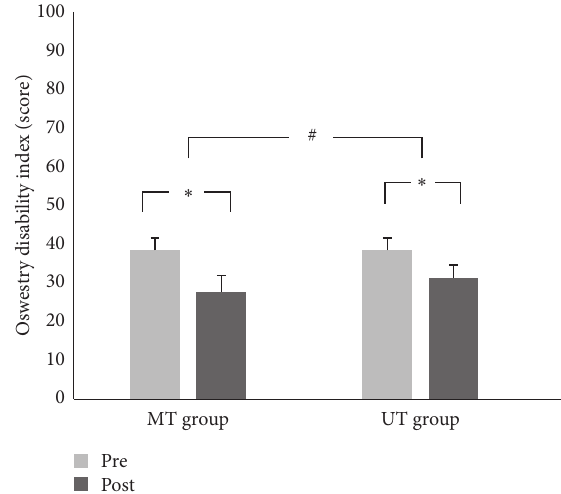
Figure 4: Change of ODI score after training. ∗ Significant dif- ference between pre and post ( p < 0 . 05). # Significant difference between MT and UT group ( p < 0 .